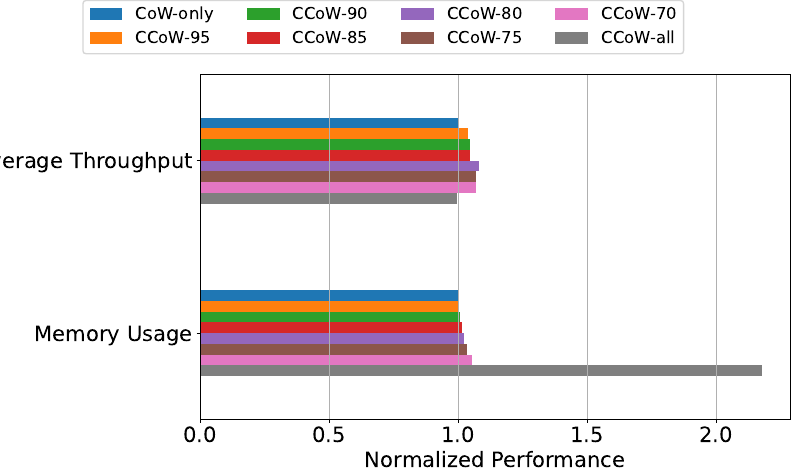
Figure 4. The performance and overhead of CCoW for various